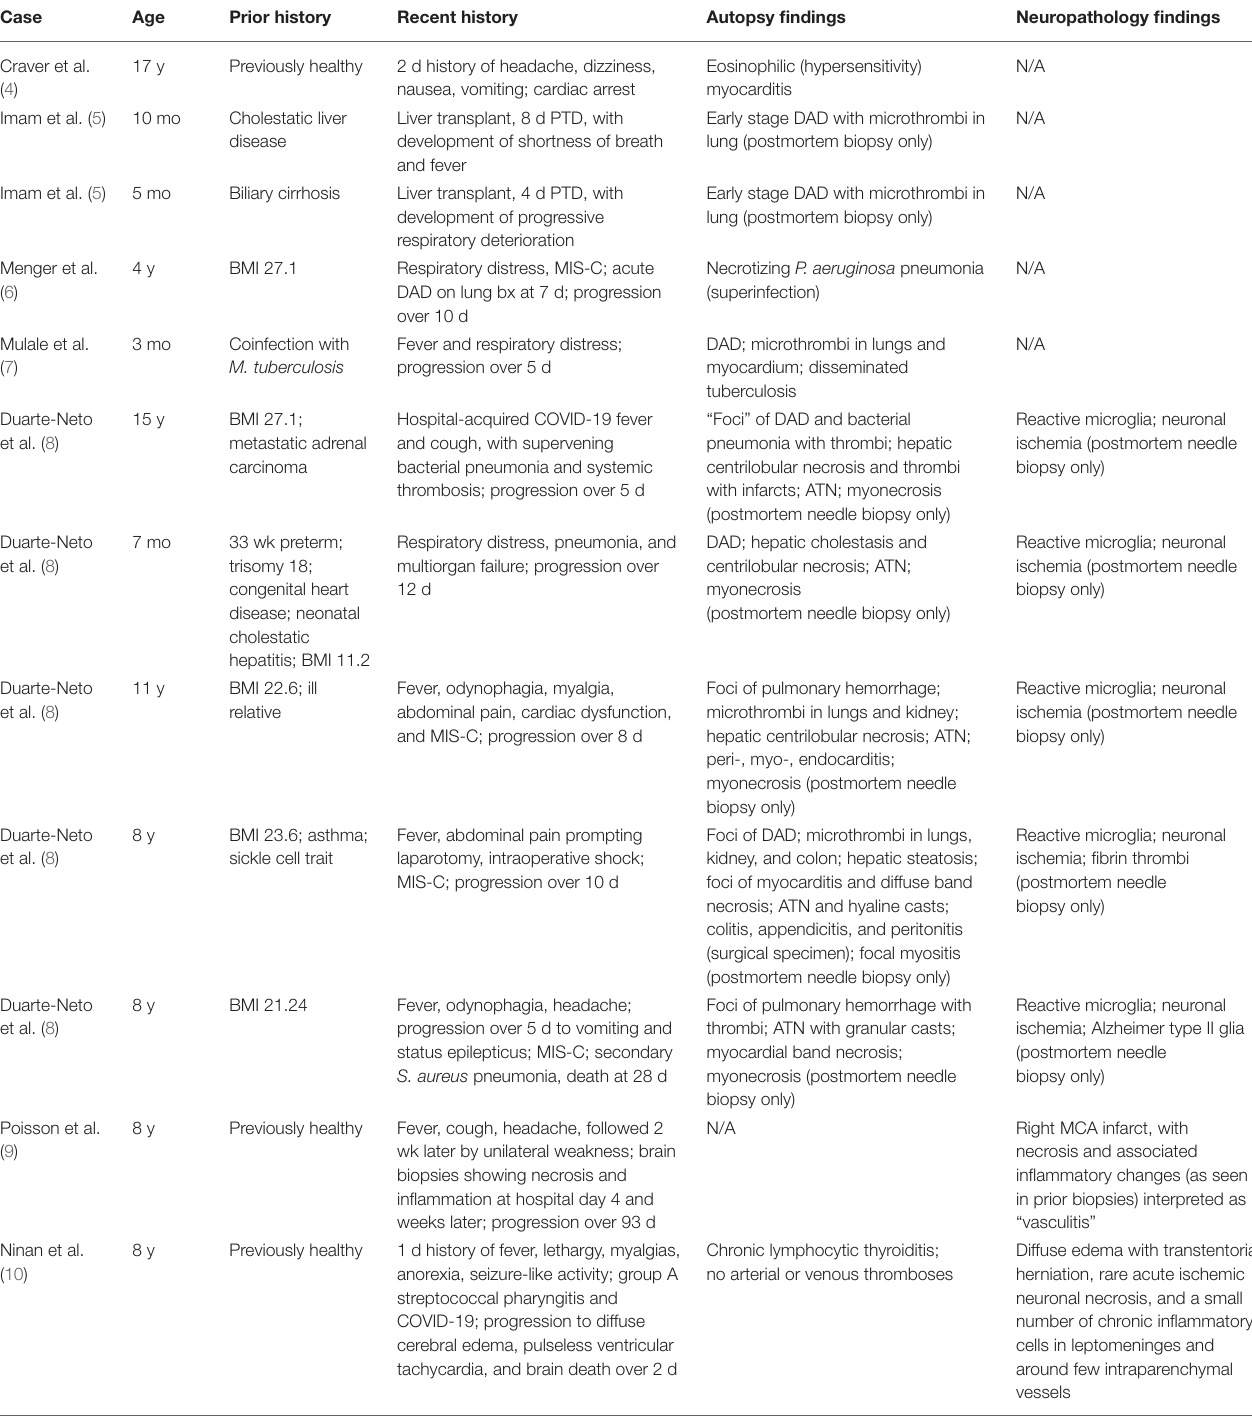
TABLE 1 | Published reports of pediatric SARS-CoV-2 autopsy